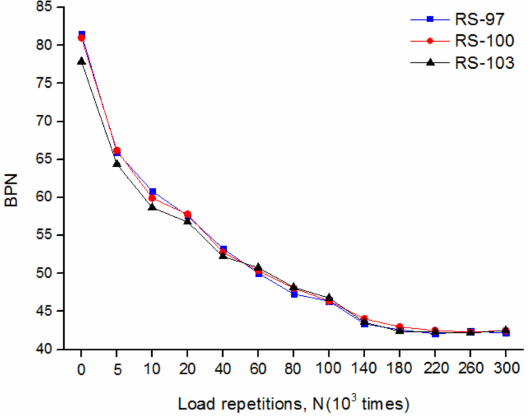
Figure 12. Changes of British pendulum number (BPN) with load